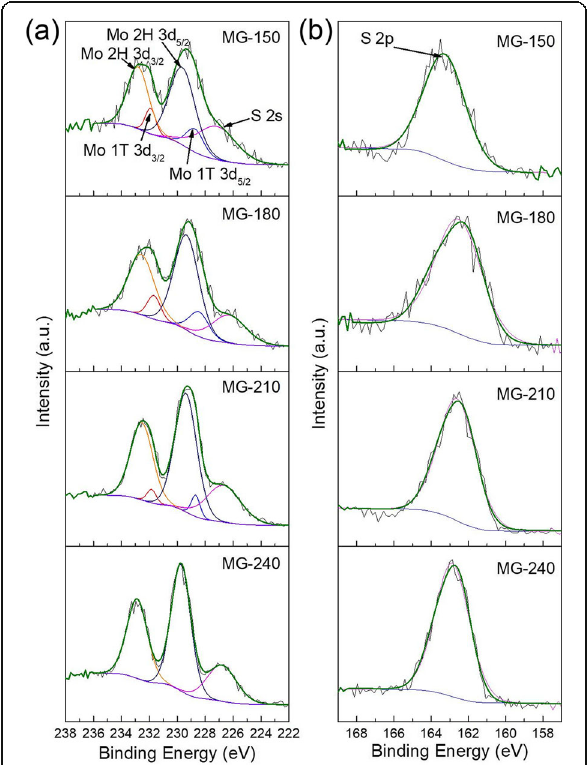
Fig. 3 Binding analysis of MoS 2 /graphene hybrids. XPS spectra of MoS 2 /graphene hybrids prepared at 150, 180, 210, and 240 °C, with ( a ) focuses Mo 3d orbits and ( b ) shows S 2p